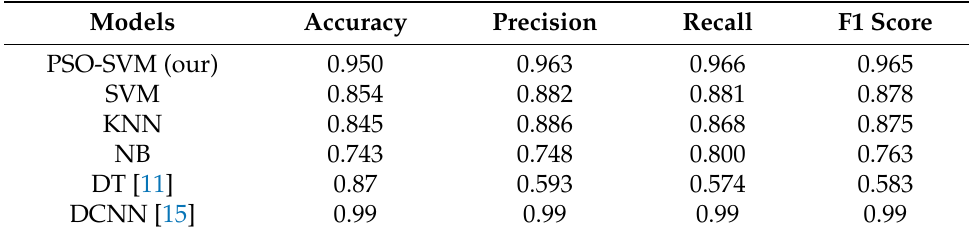
Table 6. Performance index results of four models.